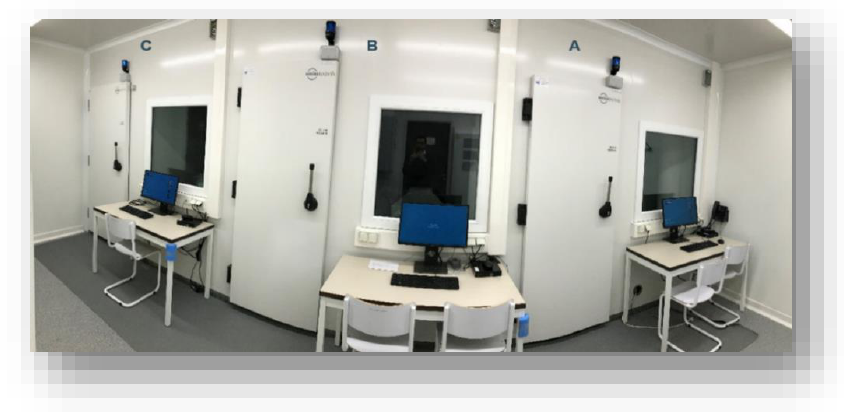
Figure 2. Photographic picture of the three climate-controlled rooms (from right to left, A–C).